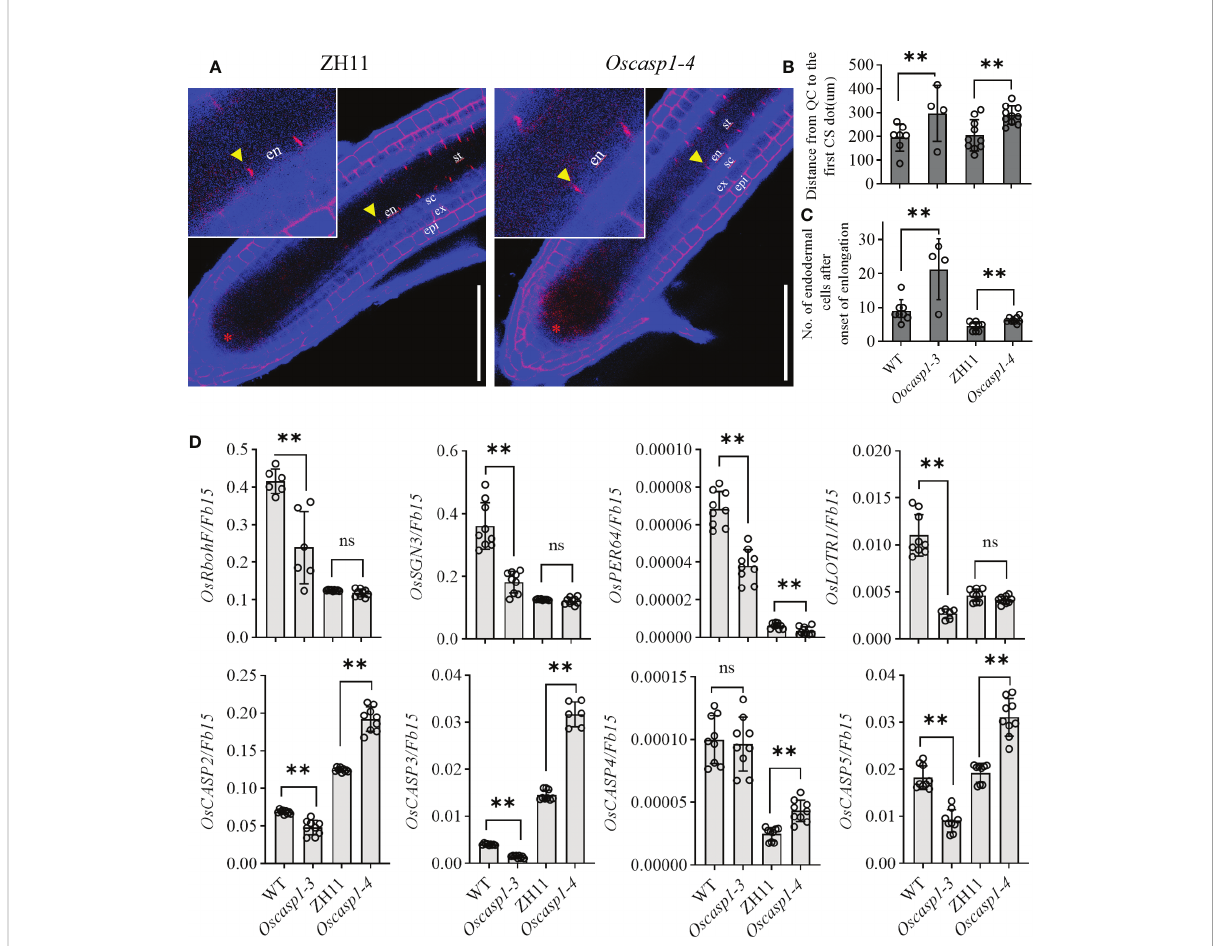
FIGURE 5 Signi fi cant delay of dot-like appearance of CS in Oscasp1 mutants comparing with wild type plants. (A) The representative CS dots of the Oscasp1-4 mutant and ZH11 SLRs stained with Basic Fuchsin and Calco fl uor White in ClearSee solution. Yellow arrow heads indicate the fi rst appearance of CS in endodermal cells. The red asterisks indicate the quiescent center (QC). st: stele; en: endodermis; sc: sclerenchyma; ex: exodermis; epi: epidermis. Scale bars = 75 m m. (B) The distance between QC and the fi rst appearance of CS in endodermis were measured. (C) No. of endodermal cells between the fi rst appearance of CS and “ onset of elongation ” were counted. “ Onset of elongation ” was de fi ned as the zone where an endodermal cell was clearly more than twice its width. (D) Expression levels of the genes encoding the proteins that could participate in CS formation. Black circles represent independent replicates of speci fi c values. Student ’ s T-test was used for statistical analysis, and ** represents statistically signi fi cant difference (p value < 0.01); ns: no signi fi cance. Fb15 (Fiber protein 15) ( Os02g0175800 ) was used as reference gene in the RT-qPCR